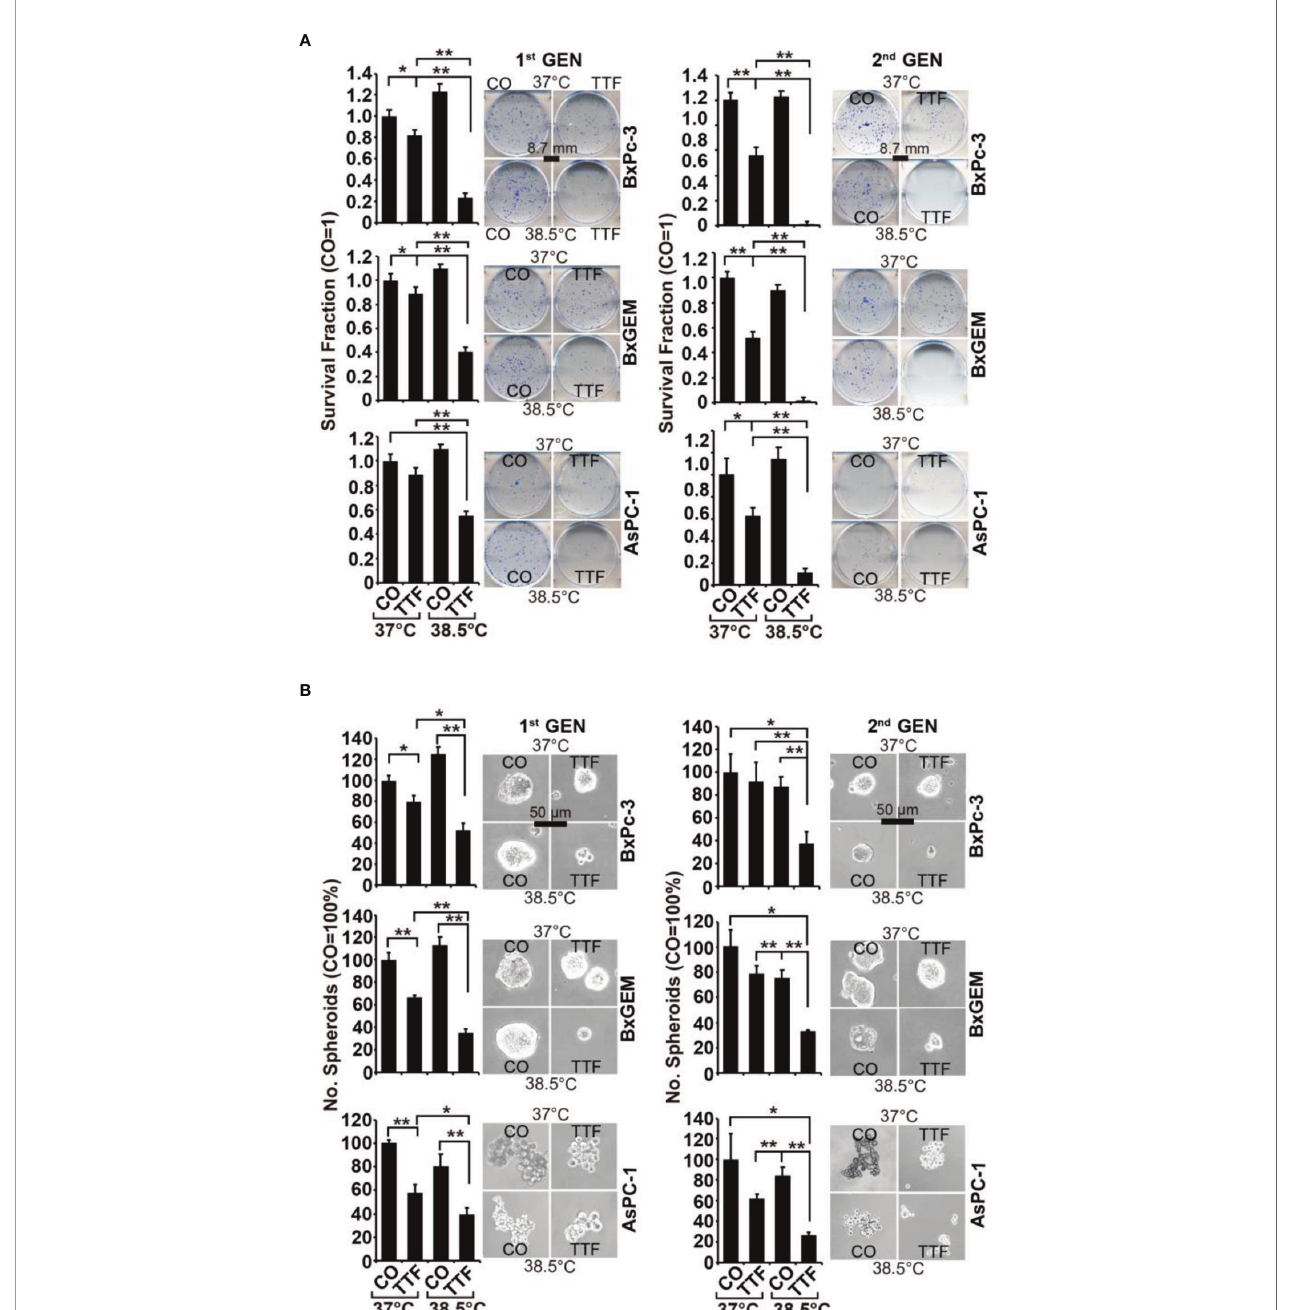
FIGURE 2 | TTField-mediated inhibition of cancer stem cell features is enhanced by hyperthermia. (A) The cells were treated as described in Figures 1A, B, (B) After 3 days, the cells were detached from the cell culture plates by trypsinization and reseeded at clonal density (AsPC-1: 1,500 cells/well; BxPC-3 and Bx-GEM: 1,000 cells/well) in 6-well plates. The cells were cultured under regular conditions at 37°C without a medium change for 2 weeks, resulting in fi rst-generation colonies (1st GEN). The number of colonies was evaluated by fi xing and Coomassie staining, followed by counting colonies with at least 50 cells using a dissecting microscope. The survival fraction and representative images are shown on the left. For the formation of second-generation (2nd GEN) colonies, surviving cells from each group of fi rstgeneration colonies were collected, reseeded and analyzed as described above. (B) After treatment, as described in Figure 1A, the cells were seeded at a clonal density of 500 cells/well in ultralow-attachment 24-well plates in cell growth factor-supplemented serum-free culture medium to induce spheroid formation. Six dayslater, the fi rst generation of spheroids developed, and the percentage of viable spheroids was evaluated by microscopy at 100× magni fi cation and counting. Representative photographs and the means are shown on the left. For the formation of second-generation spheroids (2nd GEN), surviving cells were collected from each group of fi rst-generation spheroids and reseeded and analyzed as described above. The data are presented as the means ± SDs. *P < 0.05, **P <